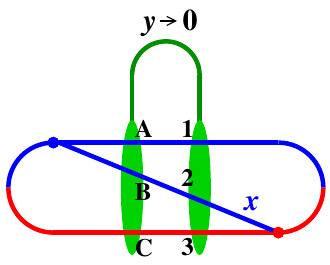
Figure 21 . Double-log diagrams. The labels A, B, C, 1, 2, and 3 for where the soft y gluon might connect the three harder gluons are provided for the sake of later naming individual diagrams. The green color of the soft gluon line is used to indicate that the line could be either blue or red